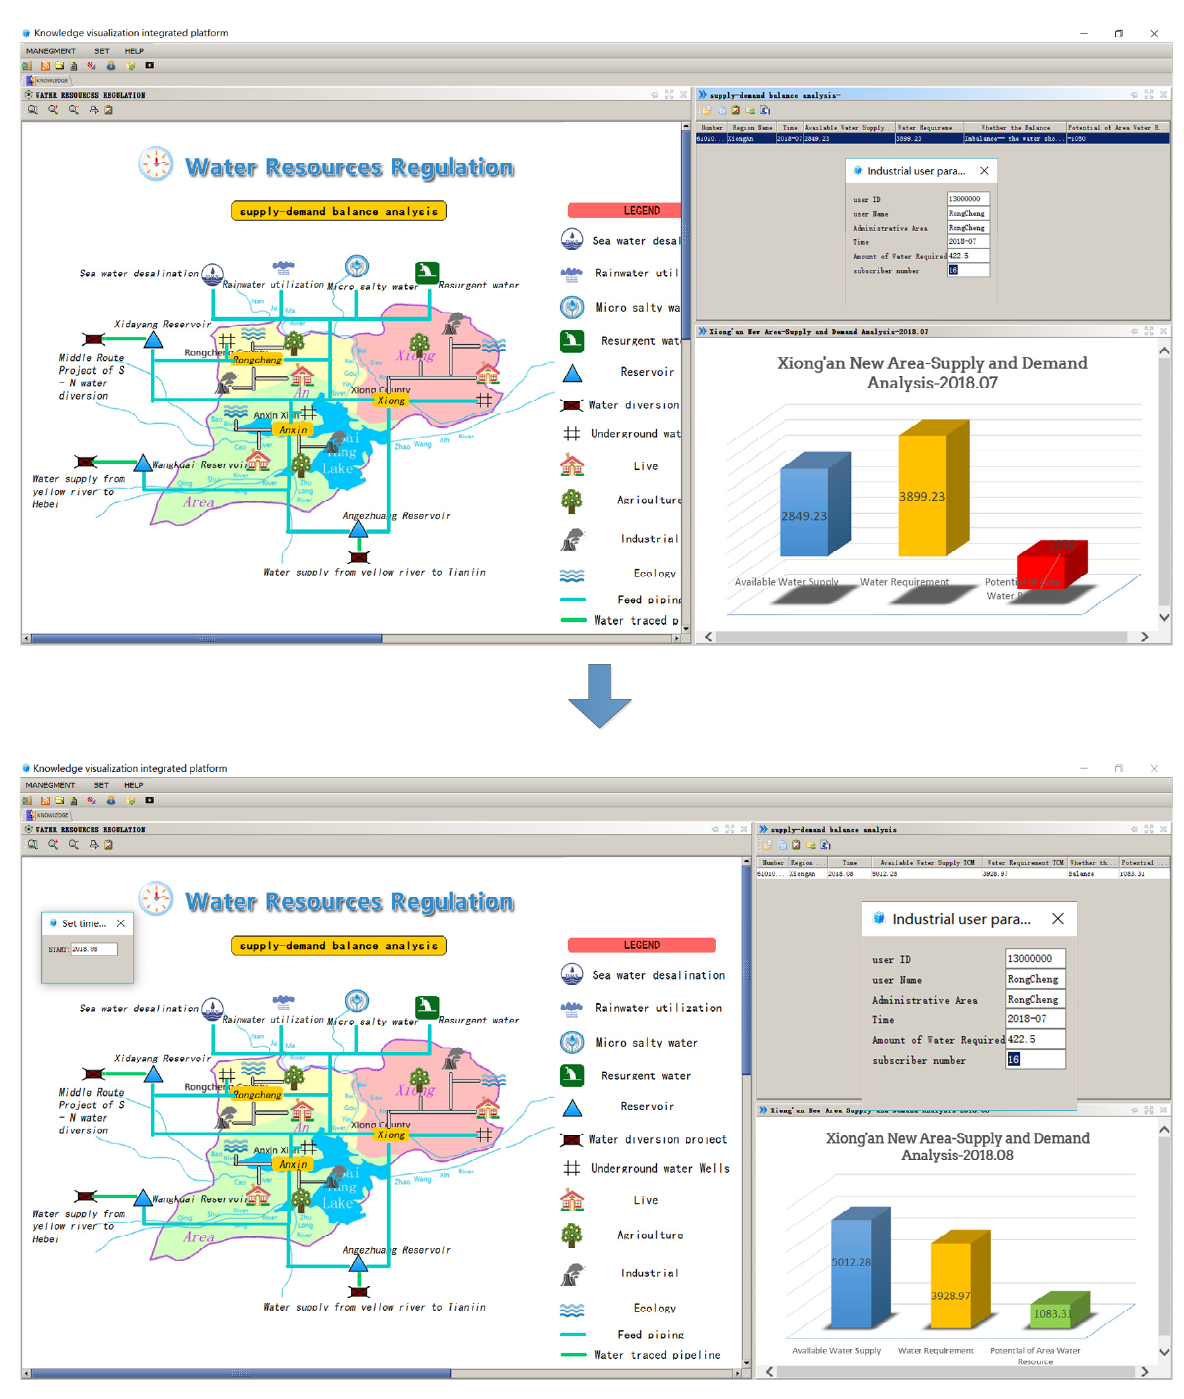
Figure 9. Example of dynamic regulation of water resources in the time scale scenario.